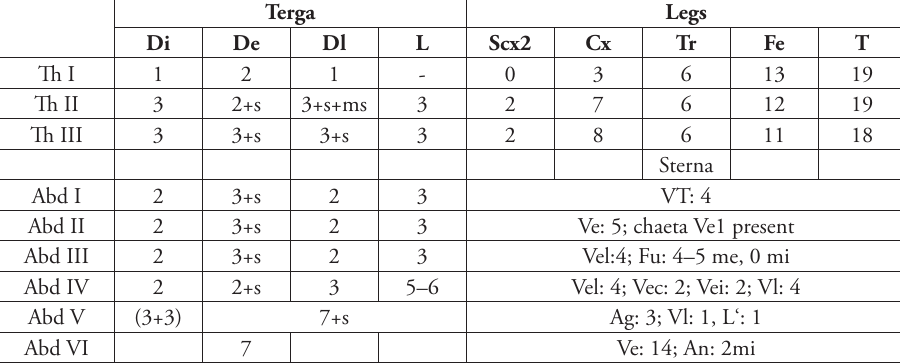
Table 1c. Chaetotaxy of Endonura longirostris sp. n.: postcephalic